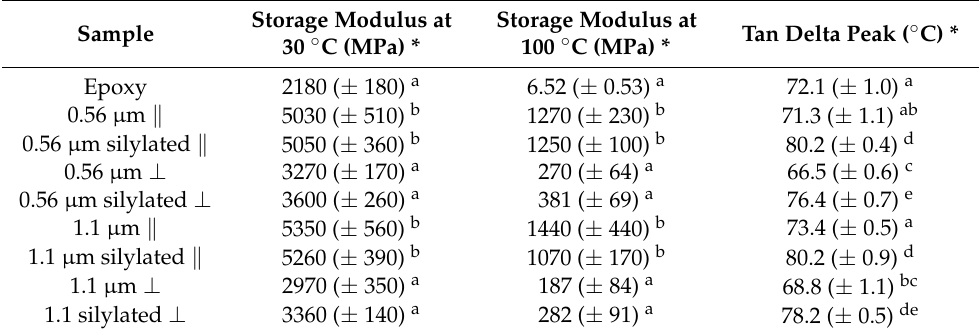
Table 2. Viscoelastic properties of the CNF filament/epoxy composites. Longitudinal ( (cid:107) ) and transverse ( ⊥ ) specimens were prepared from the composite